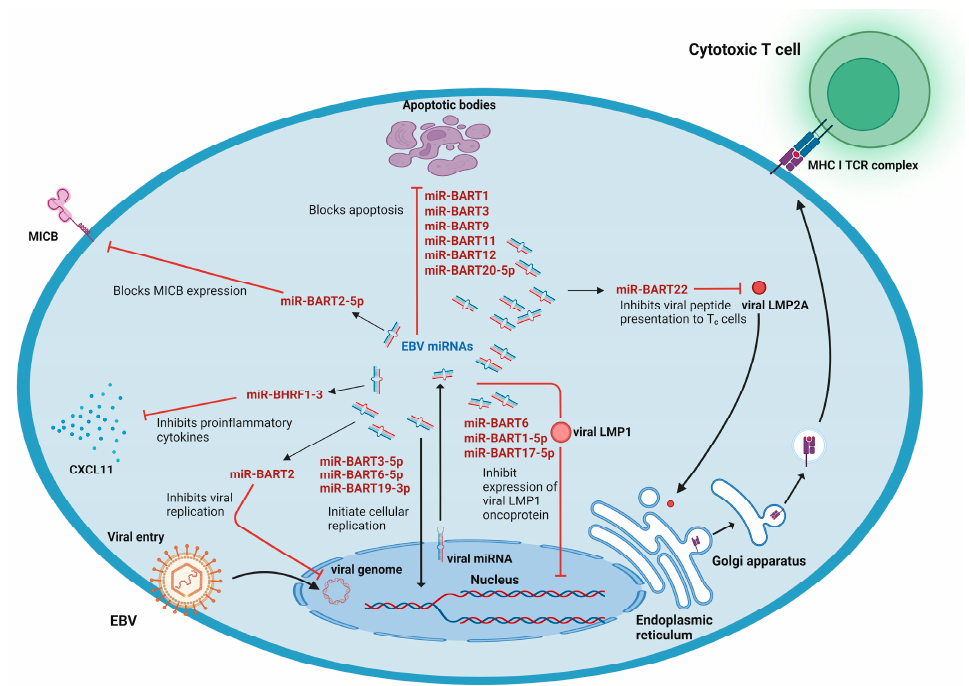
Figure 4. EBV miRNA: Function of Epstein–Barr virus (EBV)-derived miRNAs in the modulation of host signaling pathway and immune evasion. EBV-derived miRNAs downregulate the gene expression of host proteins involved in the process of apoptosis to restrict programmed cell death, tumor suppressor genes to initiate cellular replication, and proinflammatory cytokines to deregulate the pattern recognition receptors. EBV-derived miRNAs also restrict the expression of viral oncoprotein (LMP1) and inhibit viral LMP2A protein synthesis to escape immune recognition. vmiRNAs play a vital part in evading apoptosis. PUMA, a proapoptotic factor